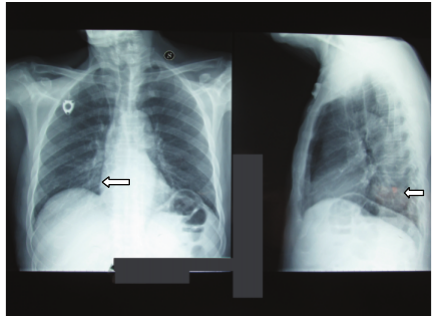
Figure 1: Chest X-ray at the admission.